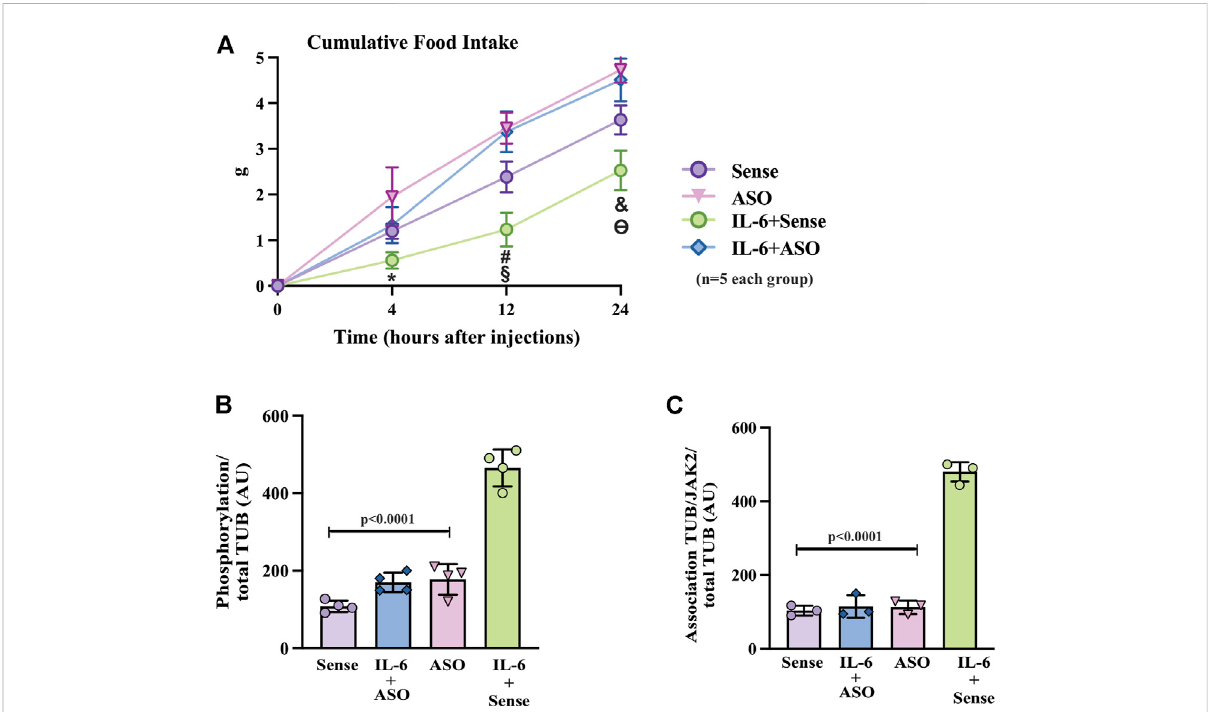
FIGURE 5 Effects of TUB knockdown on food intake in response to IL-6 ICV injection. (A) Evaluation of food intake (g) at 4 h, 12 h, and 24 h in lean mice under resting conditions treated ICV with sense; IL-6+ASO; ASO; IL-6+sense ( n = 5 each group). Representative quanti fi cation of (B) TUB tyrosine phosphorylation and (C) TUB associated with JAK2 from hypothalamus lysates from lean mice under resting conditions treated with IL-6 ICV or vehicle and pre-treated with ASO against TUB or sense. For this experiment, we used male wt/wt mice (6 – 8 weeks old) obtained from the B6- tub/tubcolony.Allvaluesareexpressedasmeans±standarddeviation(SD).Westernblotassays( n =3 – 4ineachgroup).Two-wayANOVAwasused toanalyzeA,andone-wayANOVAwithTukey ’ smultiplecomparisonstestswasusedtoanalyzeBandC.*indicatesIL-6vs.Sense,ASO,andASOplus IL-6( p < 0.0303); # indicatesIL-6vs.Sense,ASO,andASOplusIL-6( p < 0.0042); § indicatesSensevs.ASO,andASOplusIL-6( p < 0.0198); & indicates IL-6 vs. Sense, ASO,and ASO plus IL-6 ( p < 0.0092);  indicates Sense vs. ASO, and ASO plus IL-6 ( p <